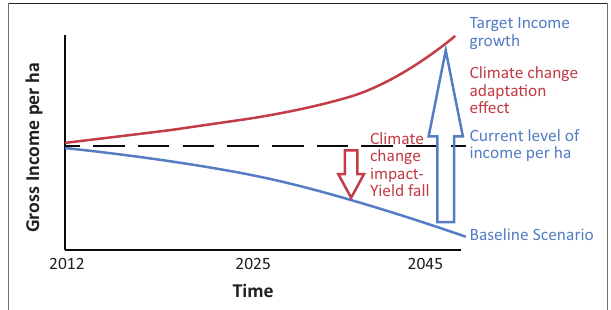
FIGURE 4: Impact of climate change on gross income per hectare (2012–2042).